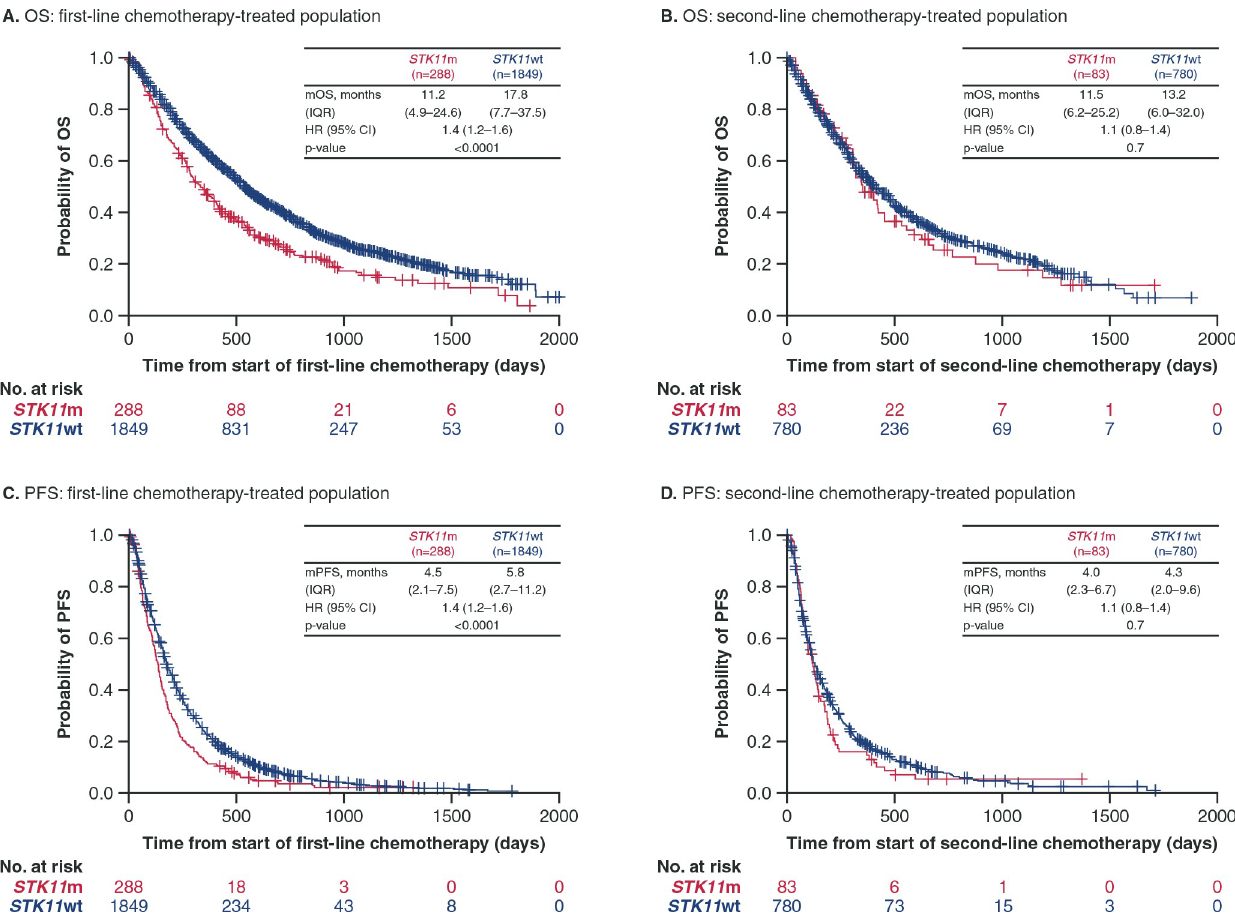
Fig 2. Overall survival and progression-free survival from start of first-line and second-line chemotherapy by STK11 mutation status. OS and PFS were assessed as time to event from initiation of line of therapy (first-line or second-line). HR values reported are adjusted HRs calculated using multivariate Cox regression models (variables in the final adjusted multivariate analysis in the first-line chemotherapy group included age at start of line 1, race, gender, smoking history, ECOG status � 60 days before start of line 1, and stage at initial diagnosis for OS and PFS [panels A and C ]; for the second-line chemotherapy group, race, smoking history, and ECOG status � 60 days before start of line 2 were included for OS and PFS [panels B and D ]). CI: confidence interval; ECOG: Eastern Cooperative Oncology Group; HR: hazard ratio; mOS: median overall survival; mPFS: median progression-free survival; OS: overall survival; PFS: progression-free